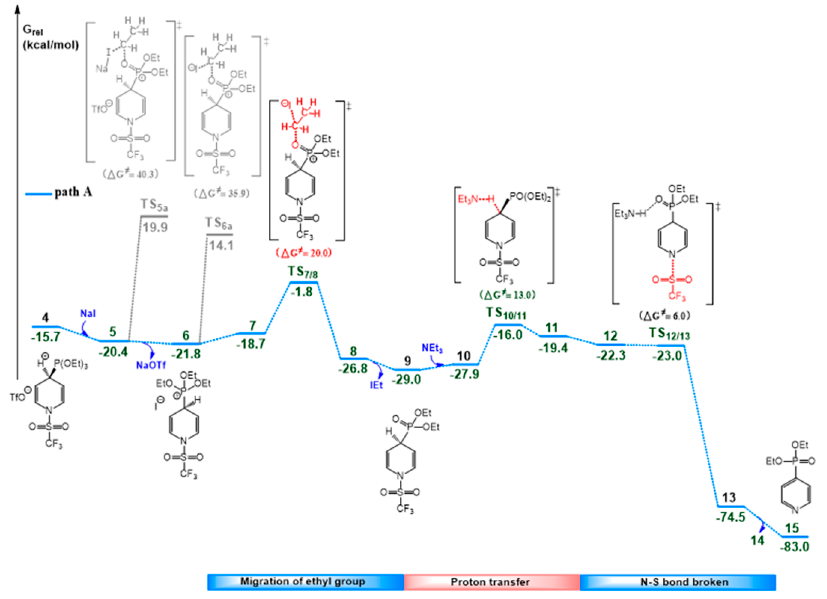
Figure 2. Free energy profile of dihydropyridine rearomatization to afford the final product (path A).